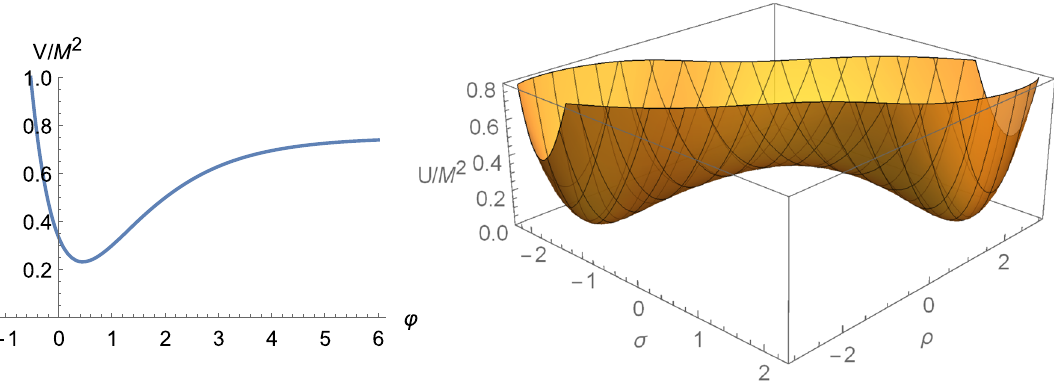
Fig. 6 On the left: the Einstein frame scalar potential V (ϕ) at ρ = σ = 0. On the right: the Jordan frame potential U (ρ,σ) . The parameters are b = 1, f = 0 . 404, c = 0, and λ = 0